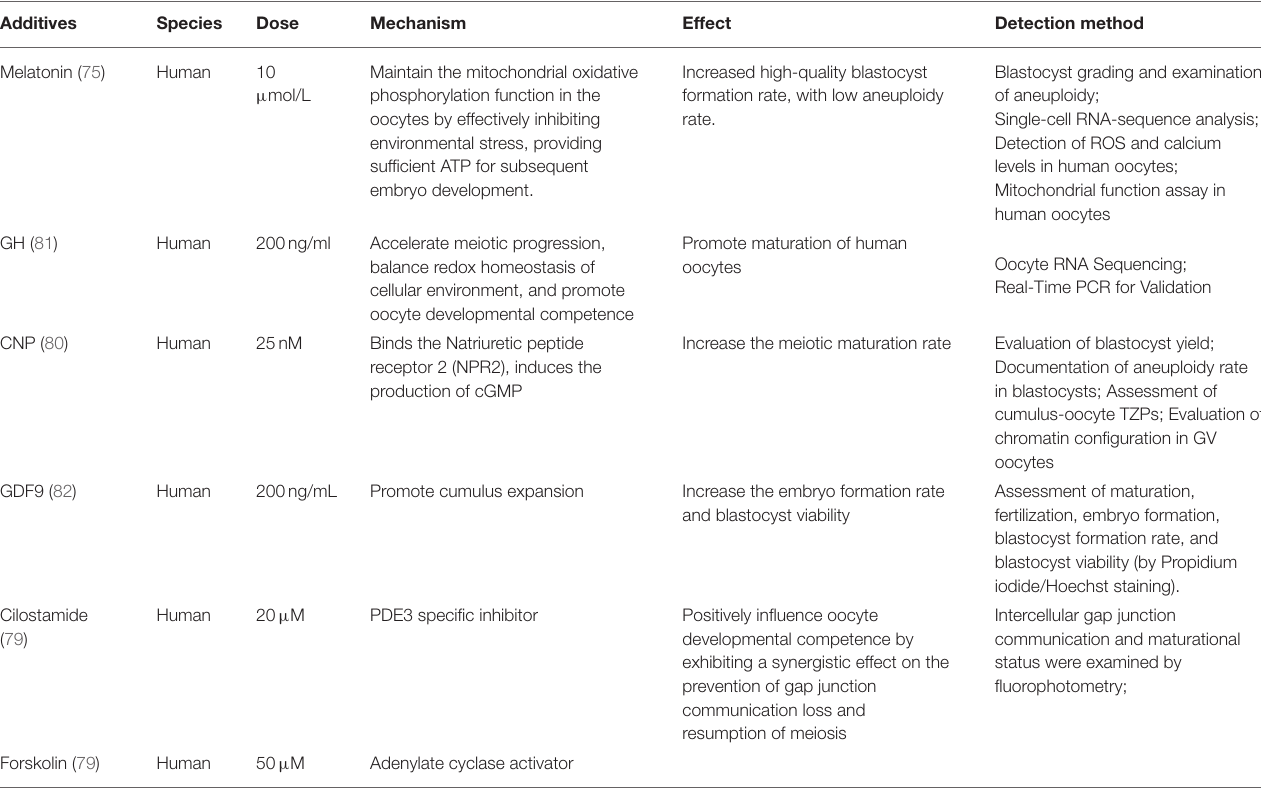
TABLE 3 | Reported additives in human follicle in vitro maturation stage.